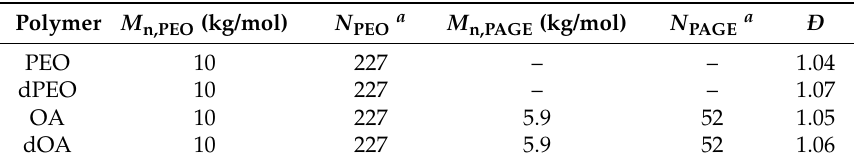
Table 1. Polymer Characteristics.